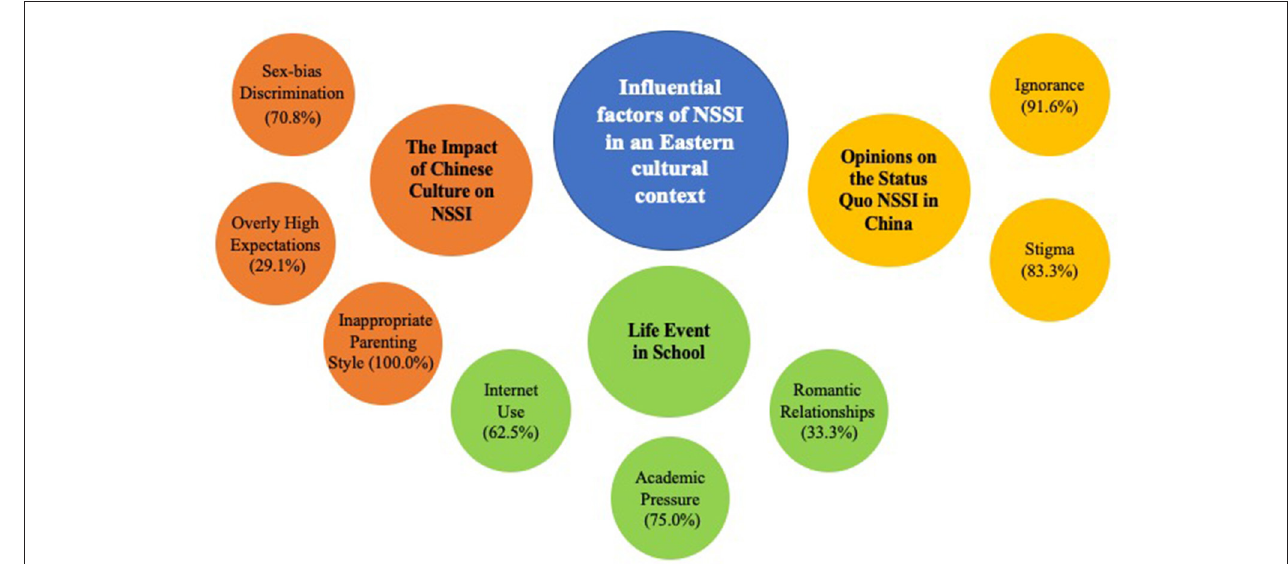
FIGURE 1 | Thematic map of the three major themes (middle circle) and eight sub-themes (small circle).